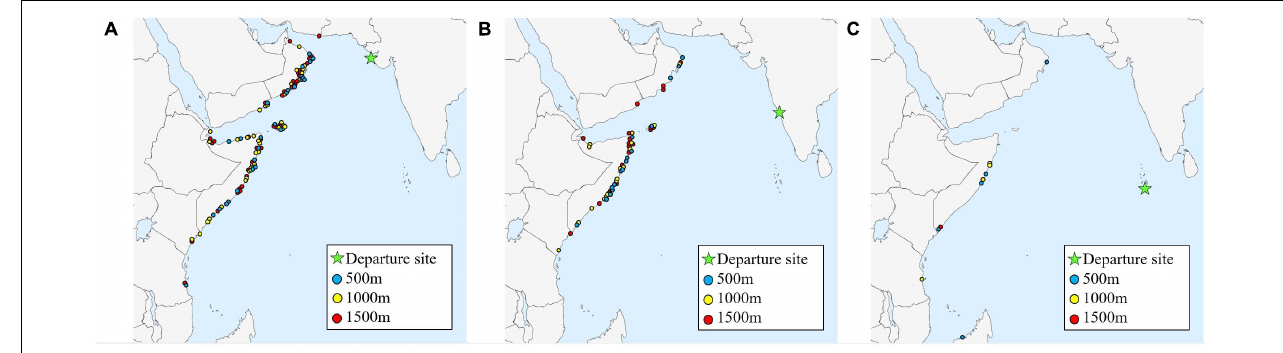
FIGURE 7 | Arrival sites for all successful autumn trajectories ( N = 167), for each starting height (500, 1,000, and 1,500 m), and three departure sites: (A) Gwarka lighthouse, northern India ( N = 105); (B) Vasco da Gama, western India ( N = 53); and (C) Malé, the Maldives ( N = 9).